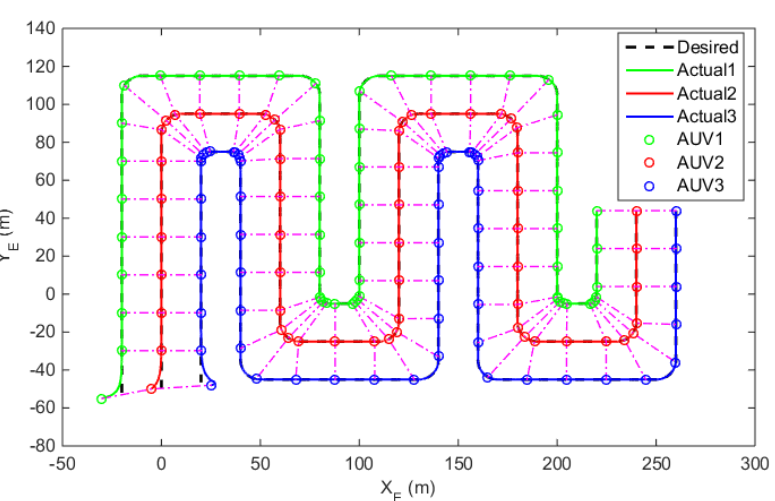
Figure 5. Region-searching performance of three AUVs under the distributed cooperative path- maneuvering control (DCPMC) approach.